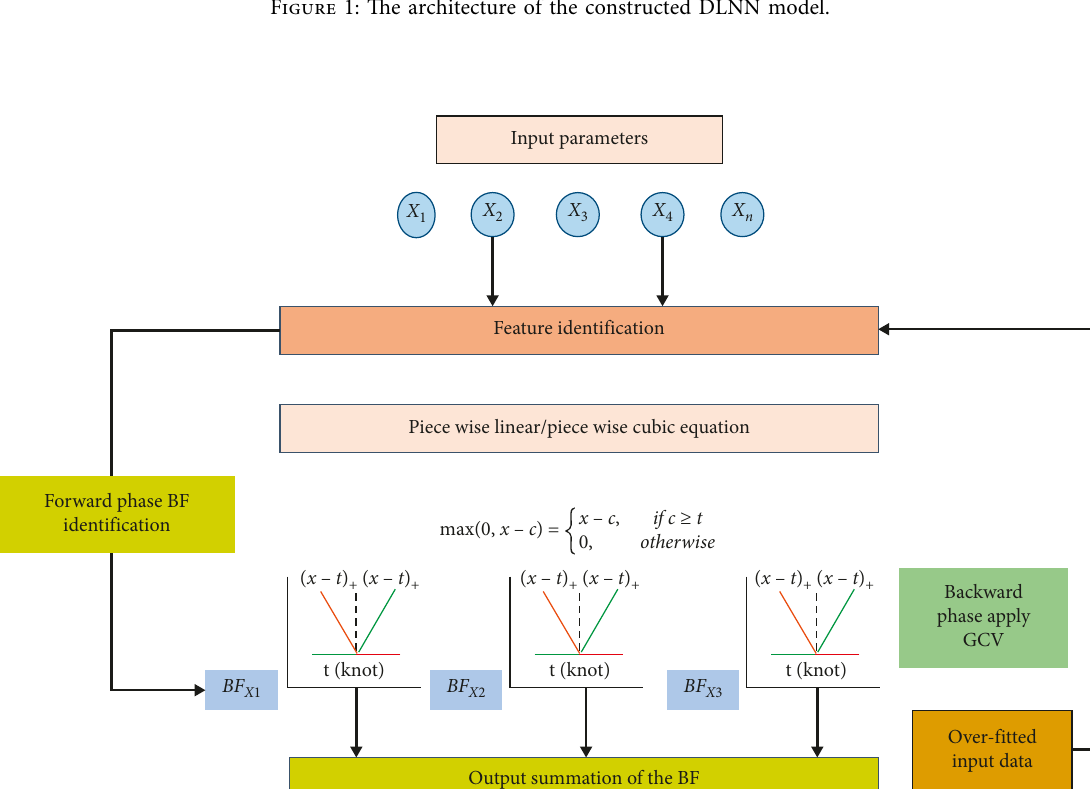
Figure 2: MARS model architecture.